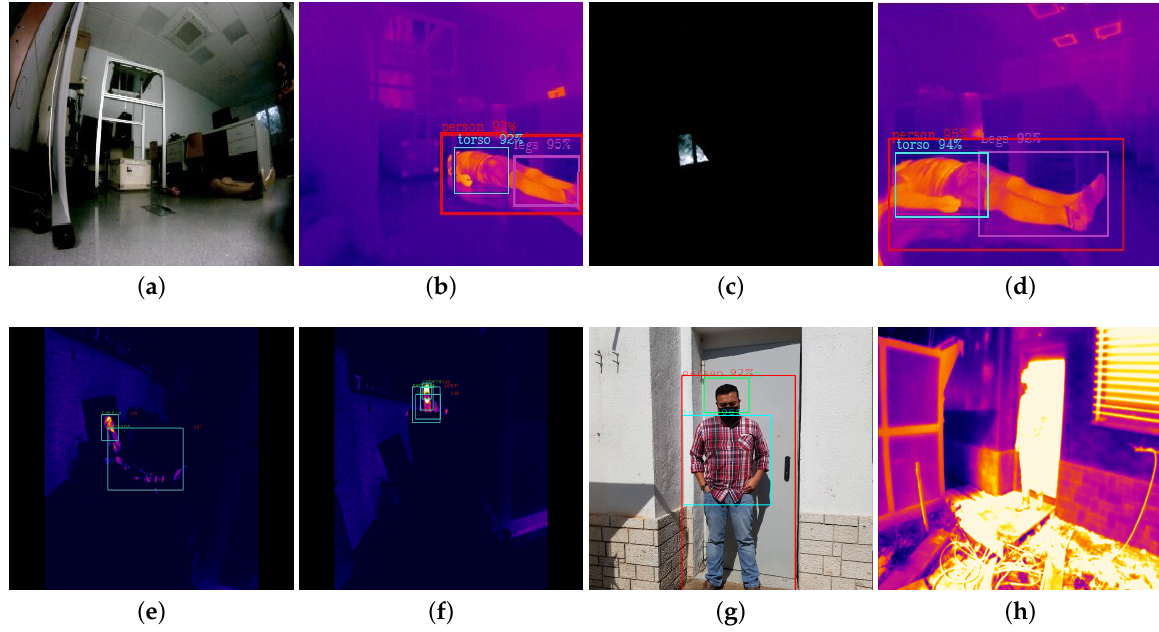
Figure 15. Evaluation of the conventional methods in front of proposed method for victims detection with different lighting conditions, using CNN-YOLOv3. ( a ) Case 1: Bad detection of RGB method in low light. ( b ) Case 1: Good detection of Thermal method in low light. ( c ) Case 2: Bad detection of RGB method in absence of light. ( d ) Case 2: Good detection of Thermal method in absence of light. ( e ) Case 3: Good detection of victims (fully covered) for the thermal method. ( f ) Case 4: Good detection of victims (partially covered) for the thermal method. ( g ) Case 5: Good detection of people in front of heat sources for RGB method. ( h ) Case 5: Bad detection of people in front of heat sources for Thermal method. Source: